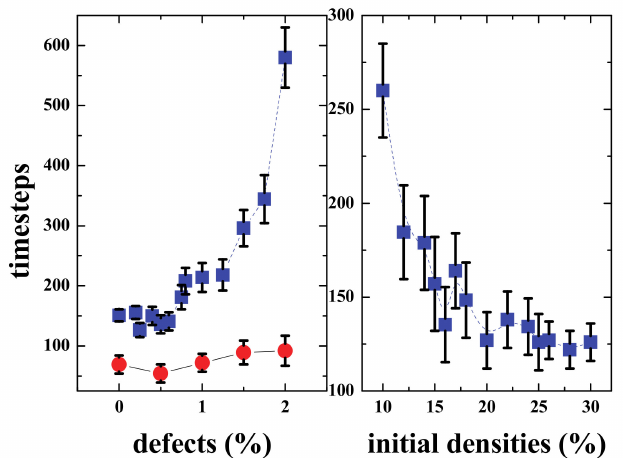
Figure 16. (Color online) Effect of the defects in the “transmission efficiency” of signals. Left figure shows the number of timesteps needed for the two communities to interact depending on the percentage of defects, for two different gaps, N/3, N being either 100 (blue squares) or 60 (red circles). (See videos 3 and 4). Right figure shows the time needed for the “transmission of the signal” between the regions “upper” and “lower,” depending on the initial density (in%) of the